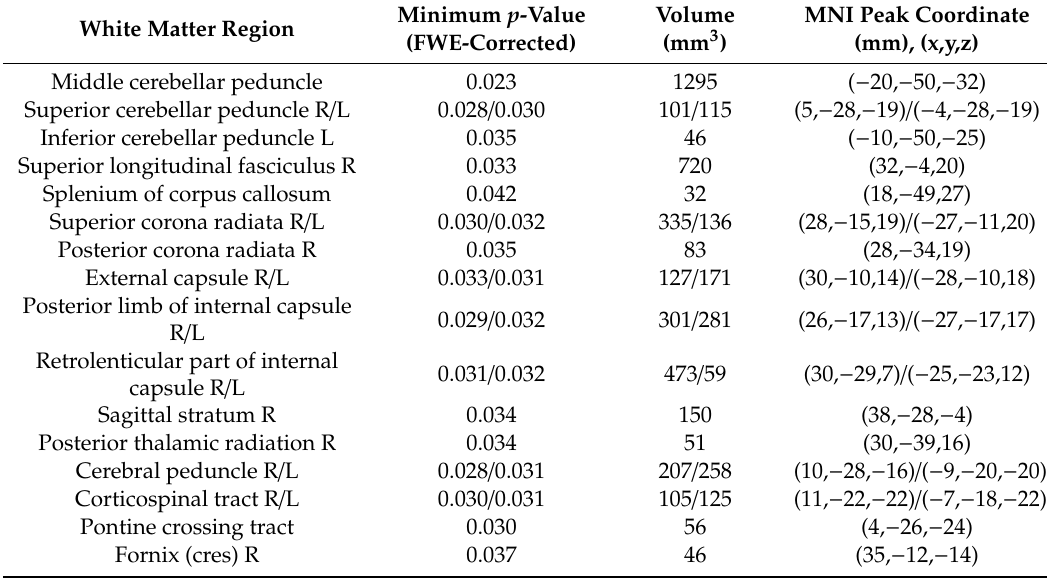
Table A1. White matter regions from the ICBM-DTI-81 White Matter Atlas for which significant decreased AD values were found in CM compared to EM including the time from onset of CM as a